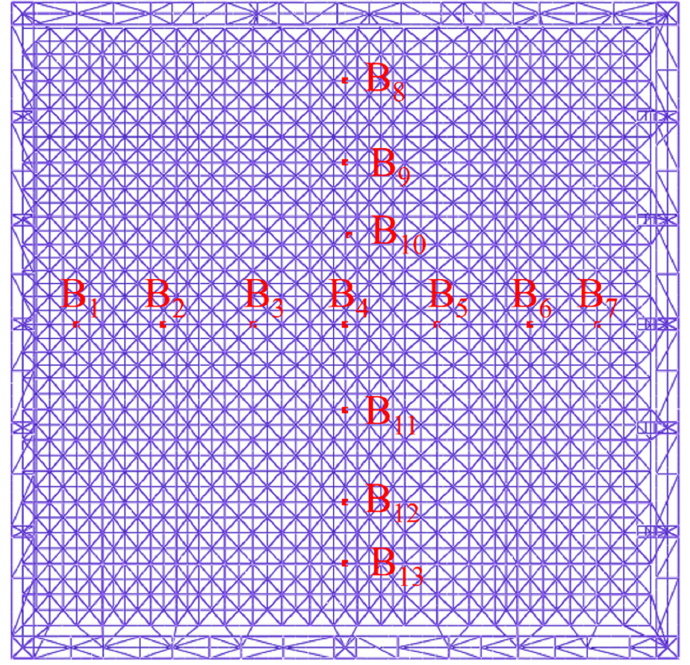
Figure 14. Numerical simulation control point.